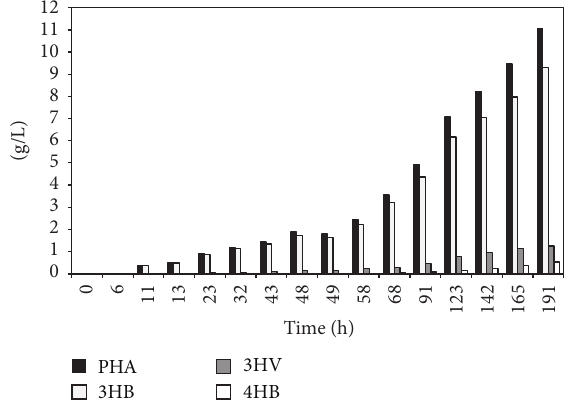
Figure 4: Formation of polyhydroxyalkanoate during